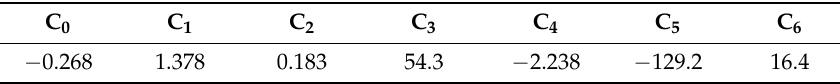
Table 2. Split-Window Coefficient